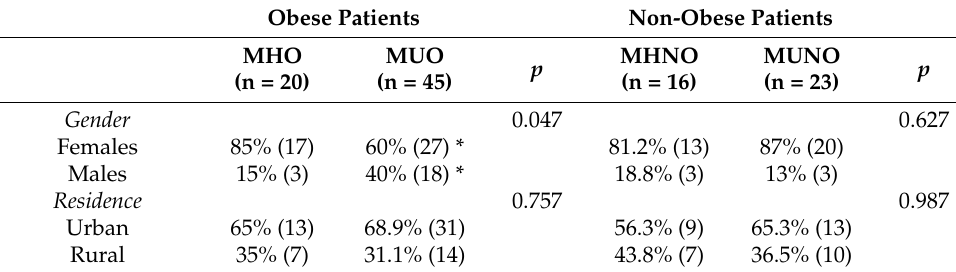
Table 1. Baseline characteristics of obesity